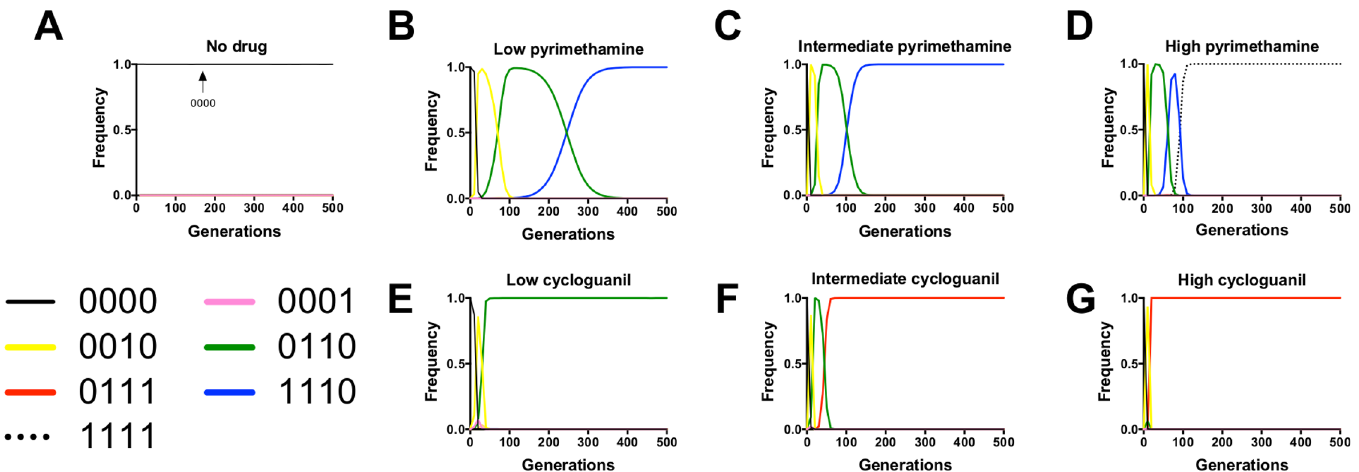
Fig 5. Simulations of evolution in pyrimethamine (PYR) and cycloguanil (CYC) reveal differences in evolutionary dynamics across environments. These are illustrative examples of the most preferred pathways for evolution at each of the simulated PYR and CYC environments. Panels correspond to several simulation scenarios: (A) no drug, (B) low PYR (1.0 uM), (C) intermediate PYR (100 uM), (D) high PYR (10,000 uM), (E) low CYC (1.0 uM), (F) intermediate CYC (100 uM), and (G) high CYC (10,000 uM). Here we observe 5 different fixing alleles across the 7 different drug environments. This is indicative of how the preferred adaptive trajectory is strongly dependent on drug environment. Not only do pathways differ, but the mean fixation times for the fixing allele also differs significantly across environment: F = 763.36, df = 5,564, P < 0.0000001; S6 Table).